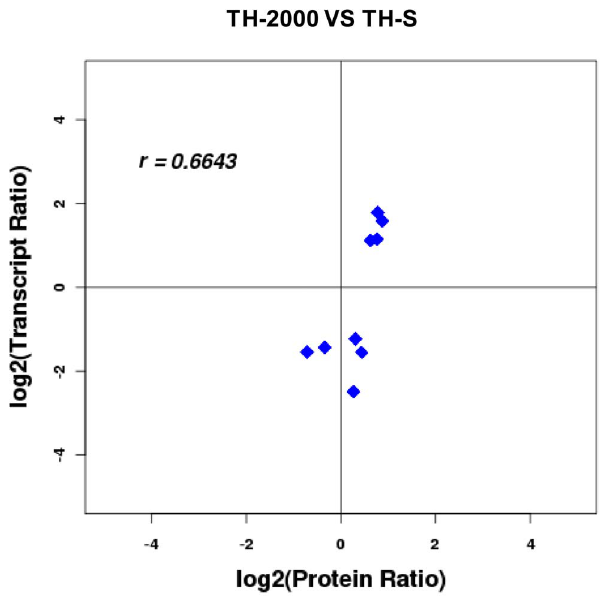
Figure 4. Quantitative real-time PCR analysis. The relative gene expression of selected target genes was normalized to a BestKeeper composed of endogenous reference genes EF-1a and b -actin . Standard errors were generated from the three biological replicates. Asterisks denote significant gene expression differences between resistant and susceptible B. tabaci , as determined by a paired t-tests (* p , 0.05, **